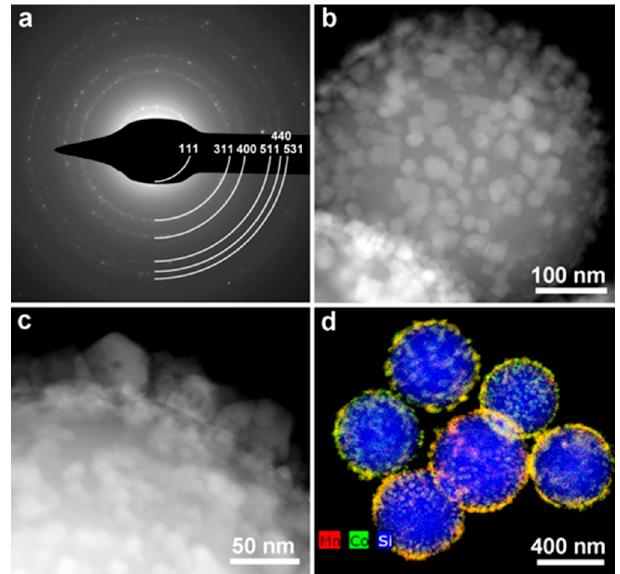
Figure A1. ( a ) Electron di ff raction pattern of the metal–organic chemical vapor deposition (MOCVD)-coated SiO 2 spheres indexed with Fd -3 m spinel structure; ( b , c ) HAADF-STEM images showing the spinel nanocrystals at the surface of the SiO 2 spheres; ( d ) EDX map of the Mn (red), Co (green), and Si (blue)